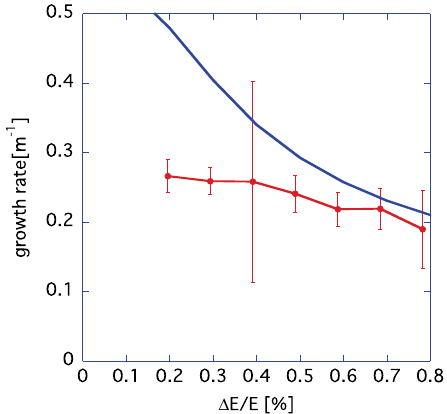
FIG. 5. The energy spread Δ E=E dependence of the maximum 10 . The simulation results (red) start beam growth rate with γ r ¼ to deviate from the theoretical ones (blue) in a small energy spread